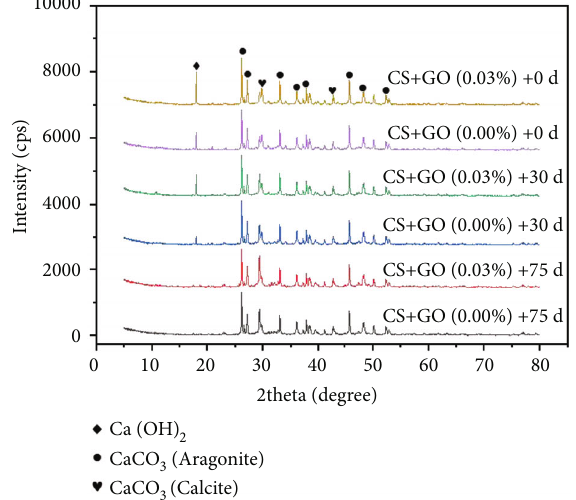
Figure 6: Phase analysis by